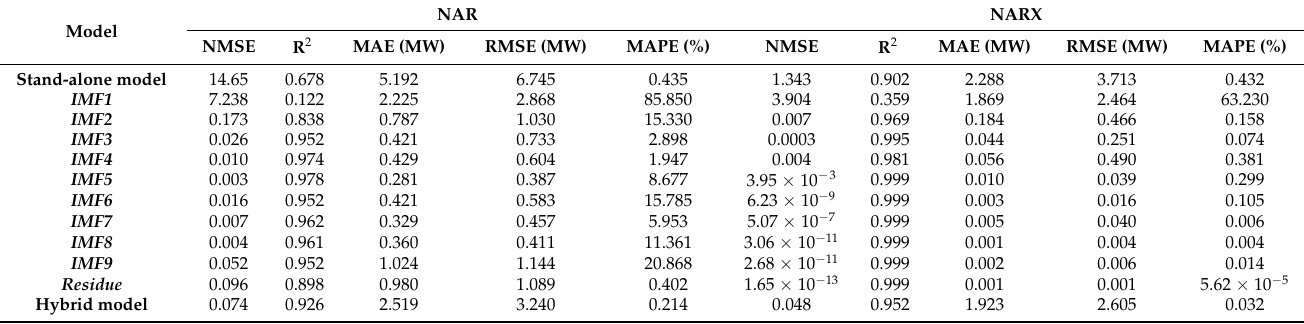
Figure 10. Comparison of the predicted power demands among the stand − alone and hybrid models over the model comparison period with the power demand record at the GS1 site. Table 4. Statistical comparisons among various predictive models for the GS1 site.